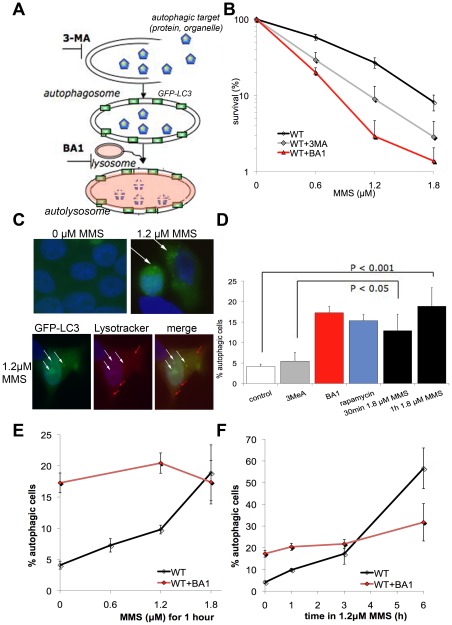
Response to MMS relies on autophagy.A) Model for induction and inhibition of autophagy. 3-methyladenine (3MeA) inhibits the formation of autophagosomes and bafiloycin A1 inhibits the acidification of the lysosomes leading to an accumulation of autophagosomes. LC3 is a marker of autophagosomes, here was tagged with GFP. B) Inhibition of autophagy decreases survival, both with 3MeA and BA1. C) Autophagy as seen by the formation of LC3-GFP-puncta showing autophagosomes in treated cells (top panel). A subset of the LC3-GFP-puncta co-stain (white arrows) with the acidic vesicles labeled by Lysotracker Red (white and red arrows) (bottom panel). D) Significant induction of autophagy after MMS treatment (1.2 µM). E–F) MMS induces autophagy in a dose and time dependent manner, whereas accumulation of autophagosomes by BA1 is not affected by MMS.